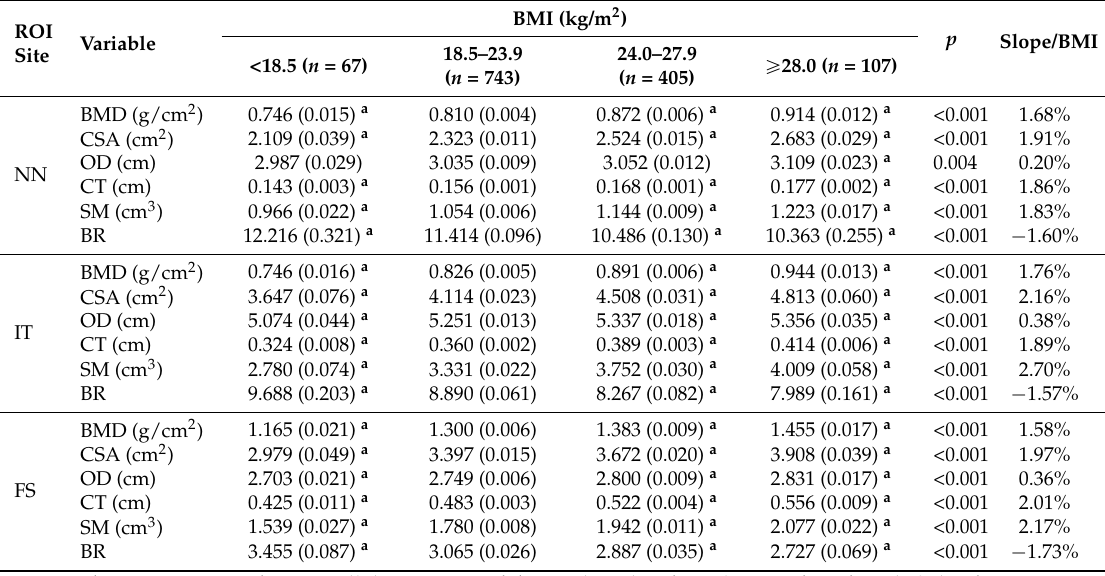
Table 4. BMD and HSA indices of subjects in different BMI